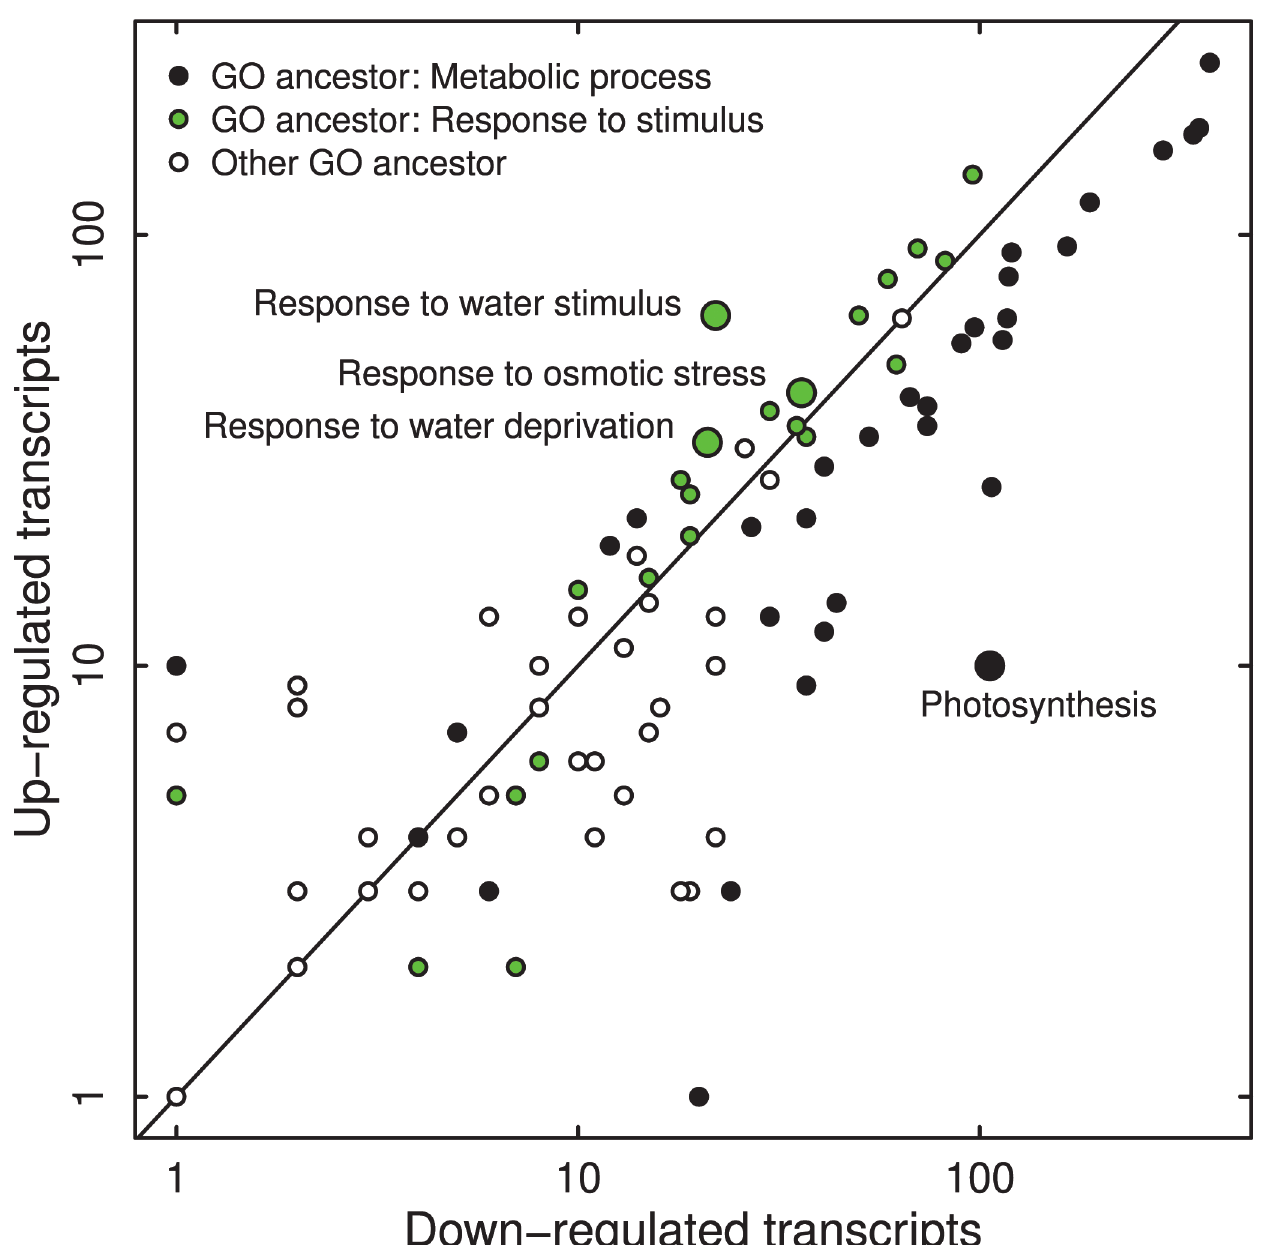
Fig 1. Log-log plot of up- and down-regulated transcripts in response to drought stress on GO-level 4 in silver fir seedlings. Transcripts are differentiated by their GO ancestor: metabolic process (GO:0008152), response to stimulus (GO:0050896) or other ancestor. Most obvious GO terms associated with drought stress, as well as photosynthesis, are highlighted and labeled